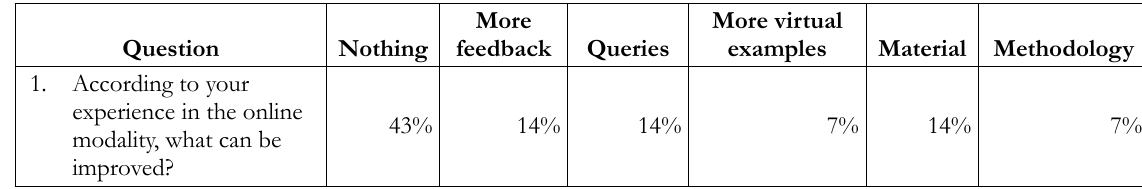
Table 11 and 12 are the results of the open questions of the student satisfaction questionnaire: